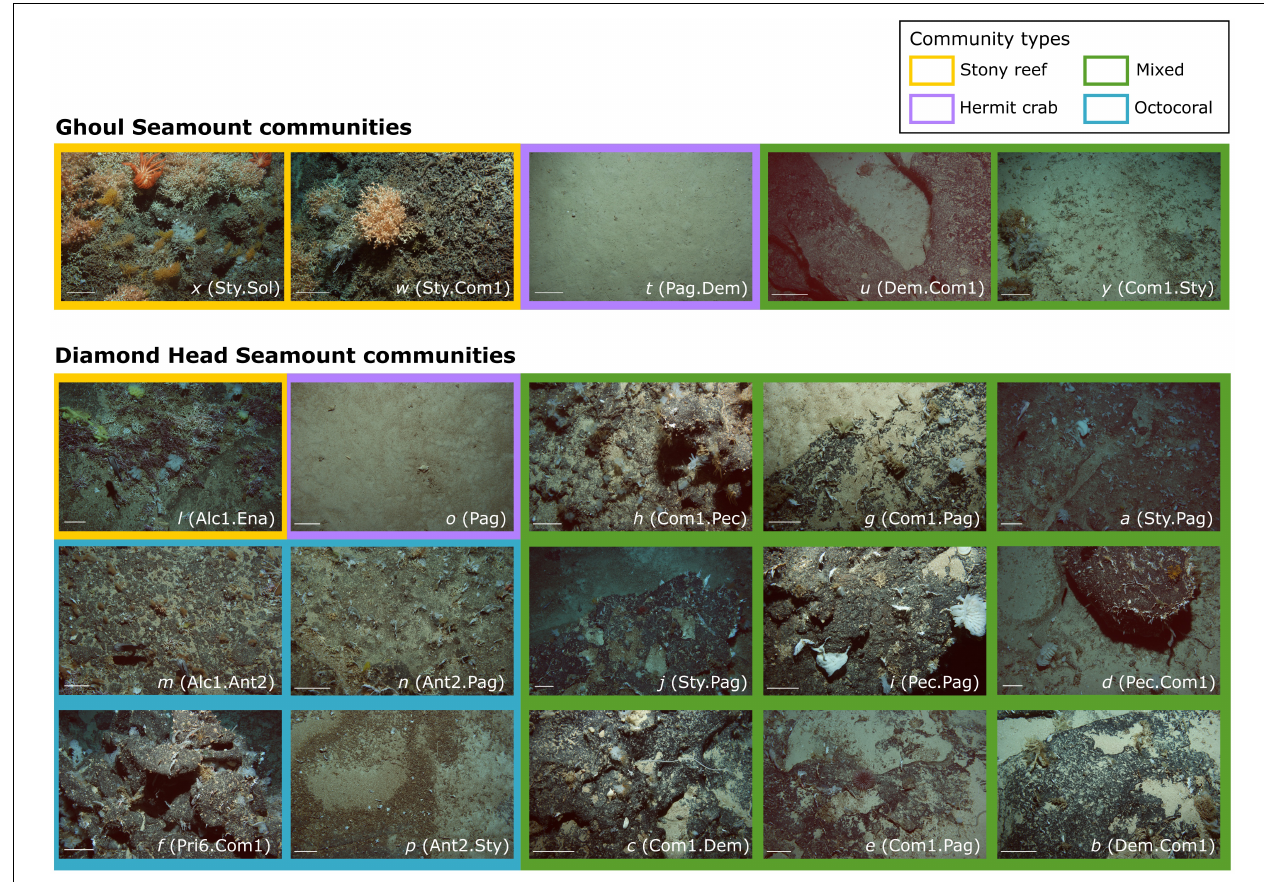
FIGURE 3 | Representative images of mega-epibenthic communities on Ghoul and Diamond Head, excluding communities with fewer than 2 samples. Three-letter community codes were assigned to represent the first 3 letters of the two taxa contributing most to within-group similarity among the characterising taxa. The communities can be broadly categorized as: stony coral reef communities (yellow), octocoral communities (blue), mixed communities characterised by demosponges, hexactinellid sponges, stylasterid hydrocorals, and comatulid crinoids (green), and communities dominated by hermit crabs (Paguridae spp., purple). See Table 2 and Results for descriptions of each community. Scale bars in the bottom left corners are 20